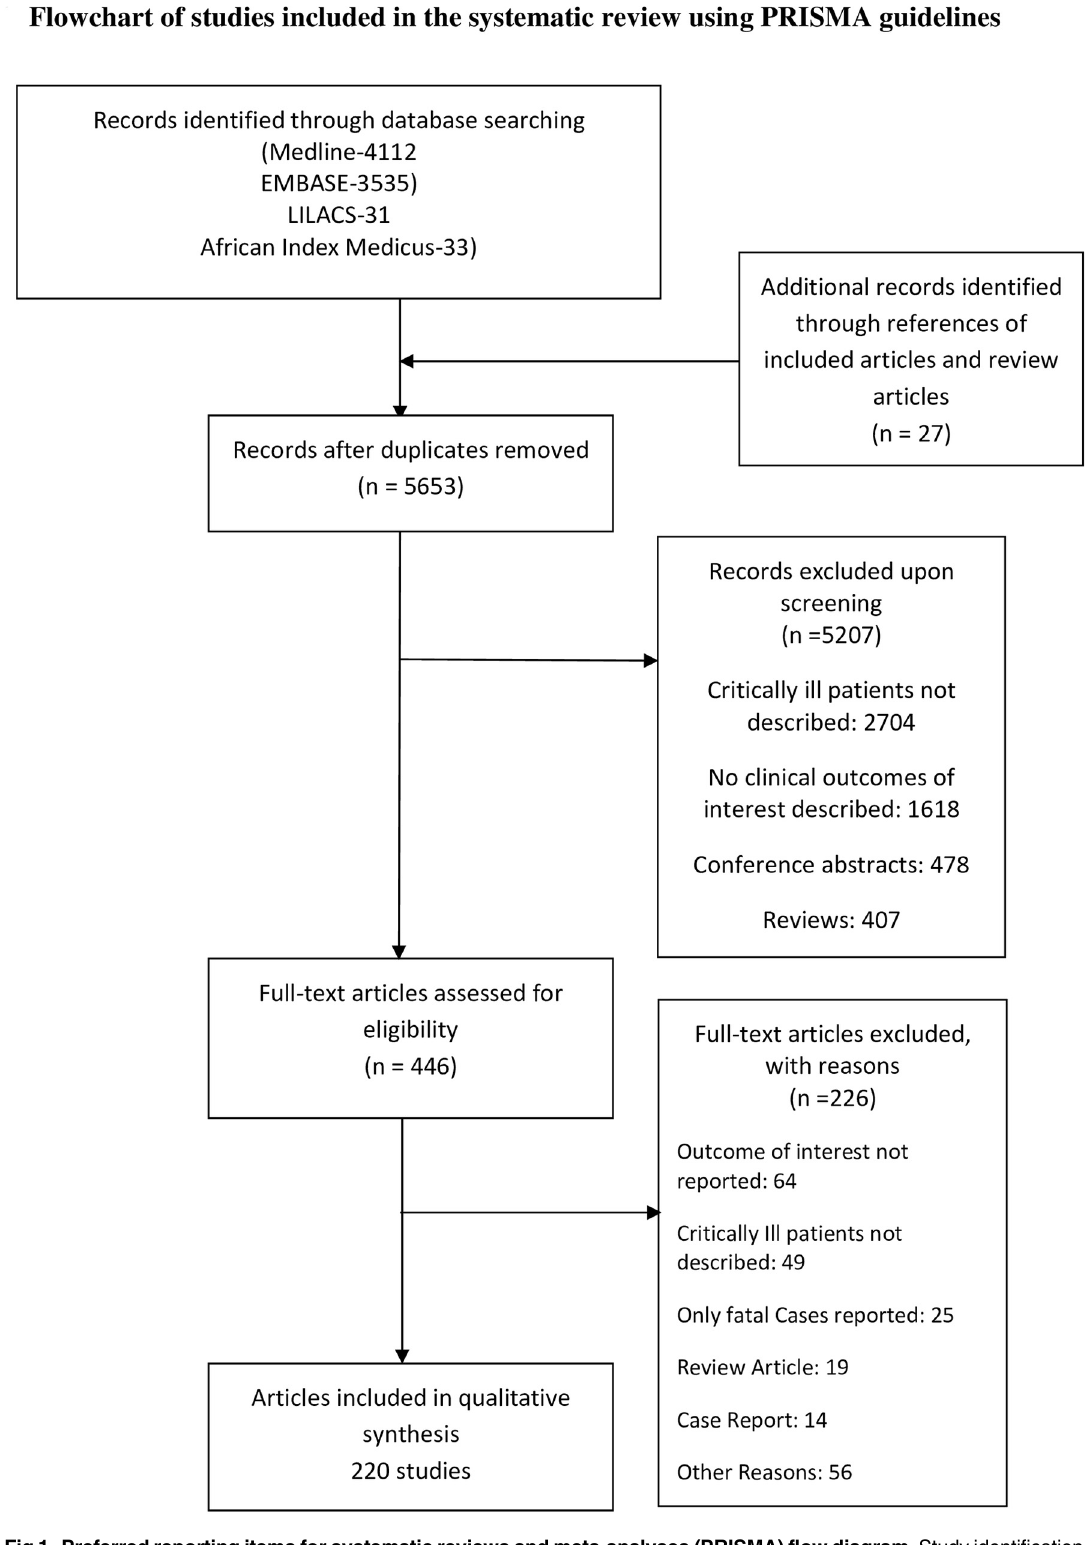
Fig 1. Preferred reporting items for systematic reviews and meta-analyses (PRISMA) flow diagram. Study identification and selection process.